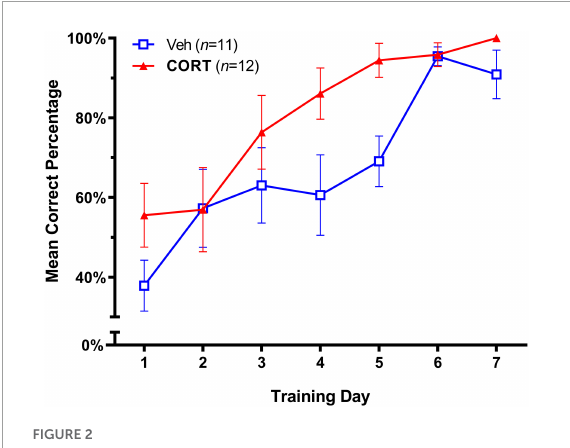
FIGURE2 Effect of CORT administration during adolescence on response learning in adulthood (Mean Percent Correct ± SEM). Exogenous CORT administration significantly enhanced task acquisition.